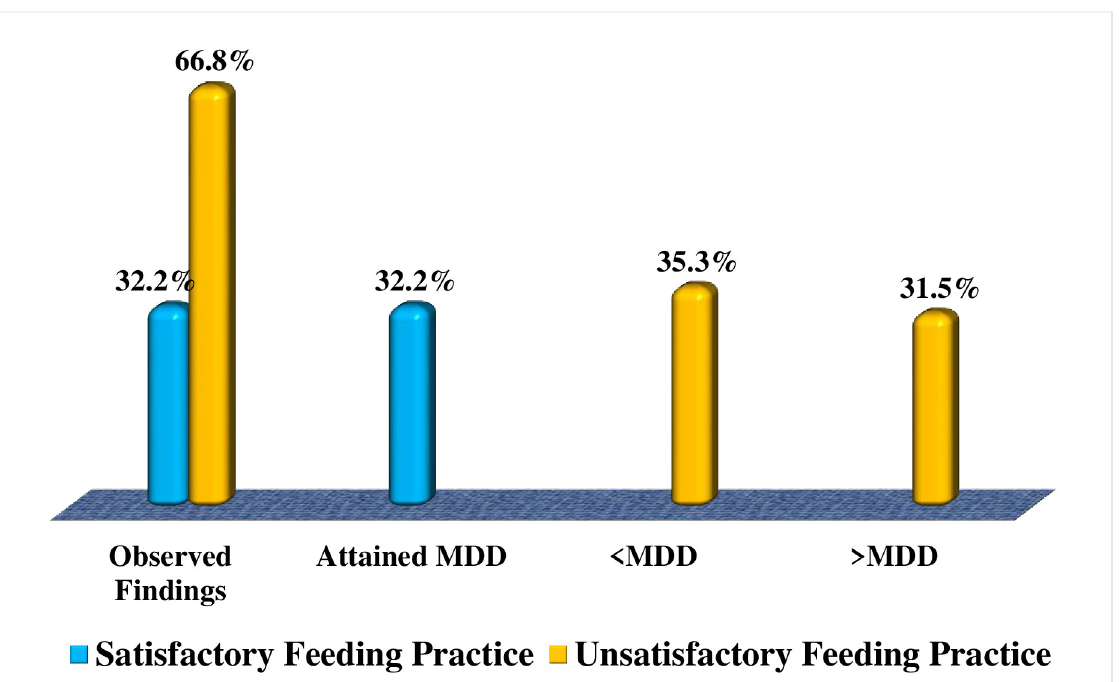
Fig 3. Proportions distributions of caregivers’ feeding practices of dietary diversity based on recommended minimum dietary diversity (MDD). Source : Field Data (2022).